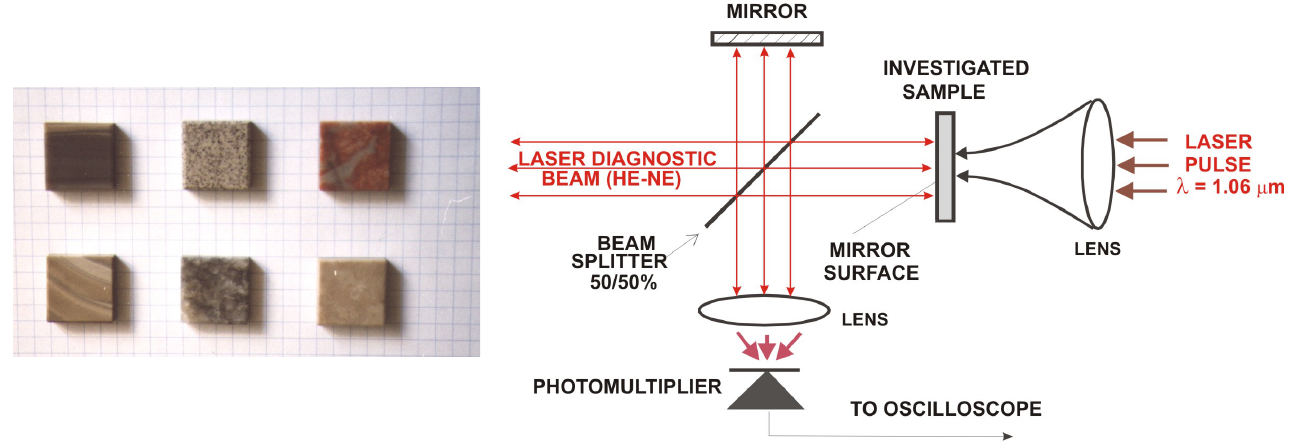
Figure 22. Scheme of experimental arrangement with Michelson interferometer.